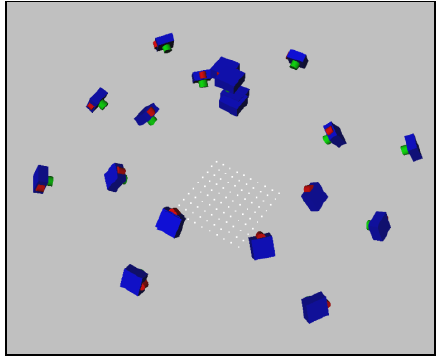
Figure 3: The image block used for camera